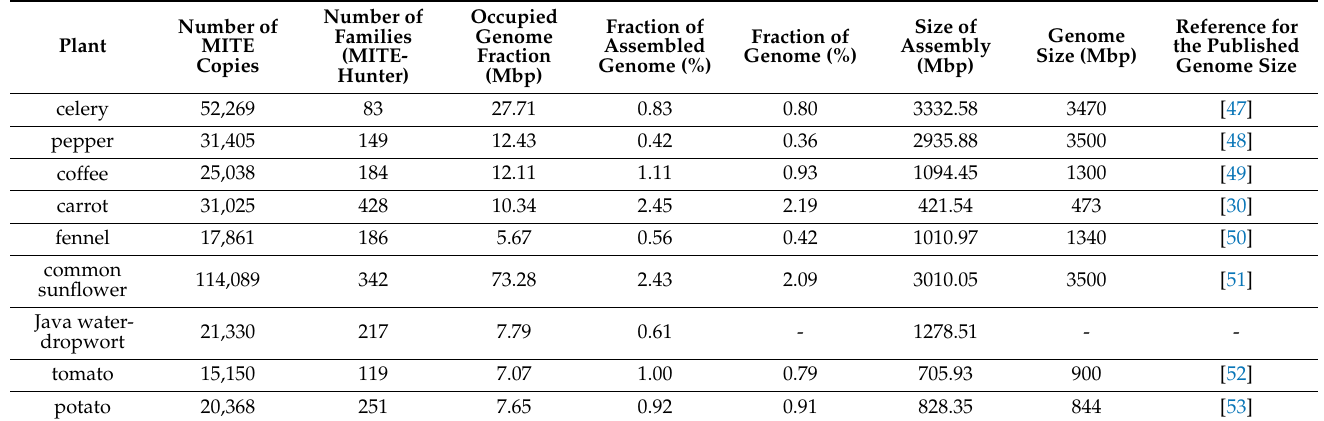
Table 2. MITEs identified in nine Asterid